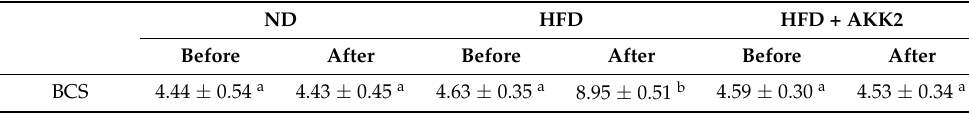
Table 4. The body condition scoring results of